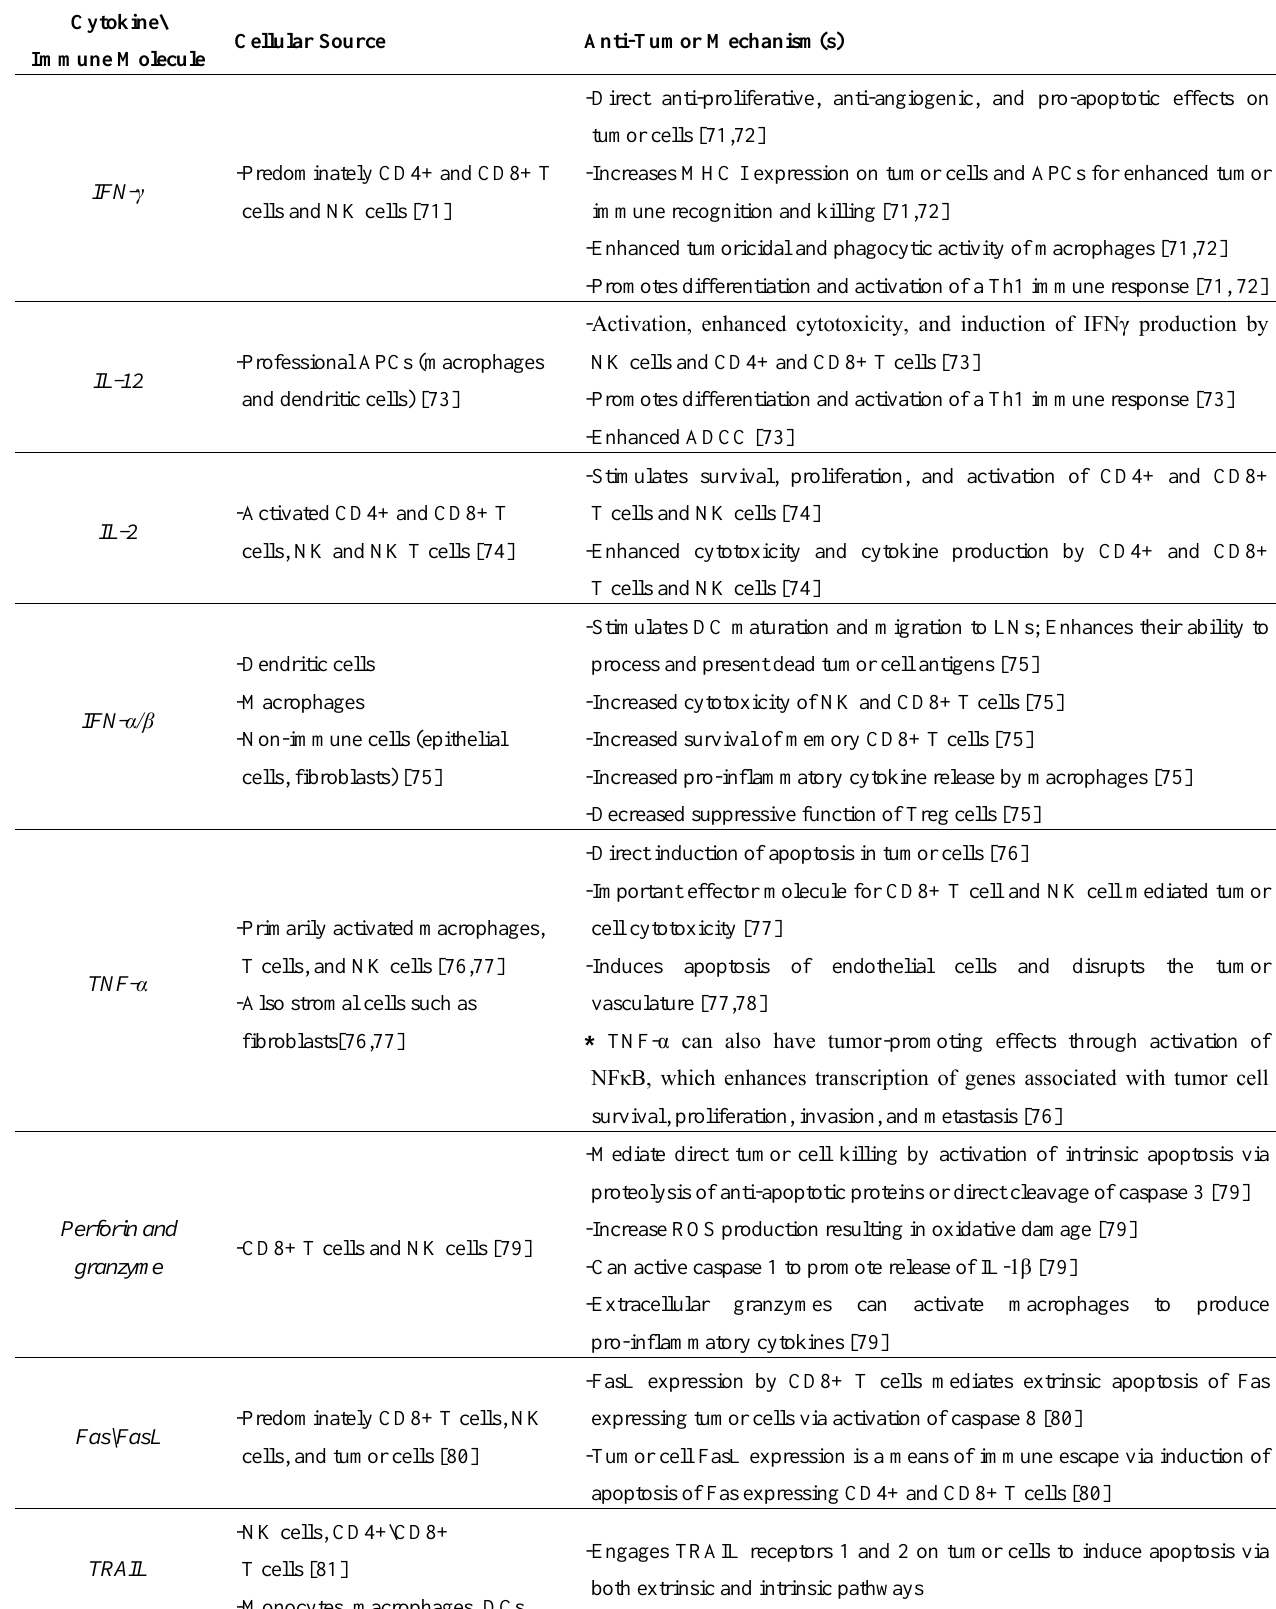
Table 1. Anti-Tumor Immune Effector